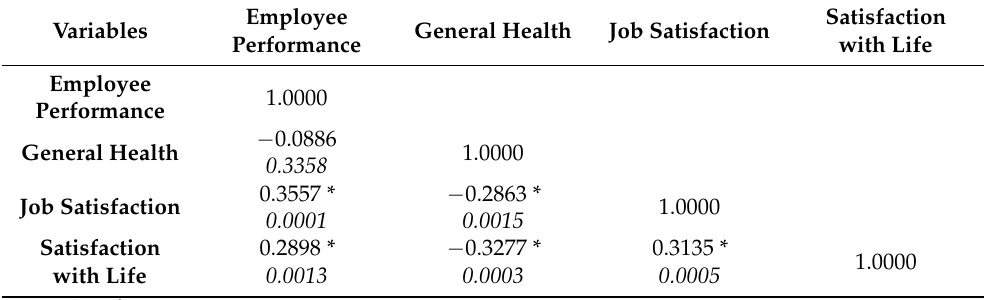
Table 2. Estimated correlation matrix and the significance of self-report